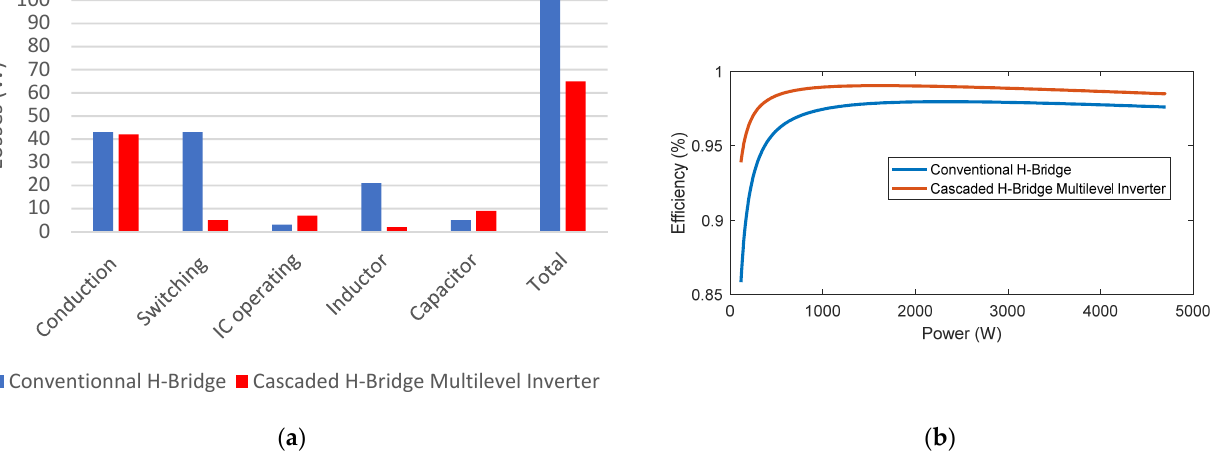
Figure 7. ( a ) Losses distribution comparison at maximum output power ( b ) Efficiency comparison.